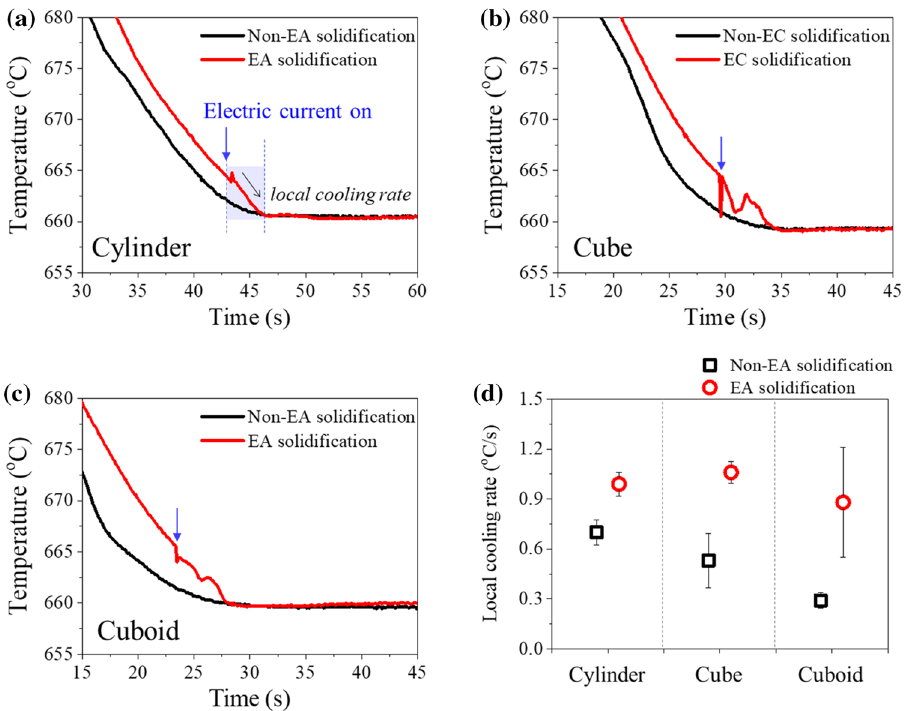
Figure 3. Comparison of cooling curve between non-EA solidification and EA solidification of ( a ) the cylinder-, ( b ) cube-, and ( c ) cuboid-shaped cavities. ( d ) Local cooling rate at each cavity